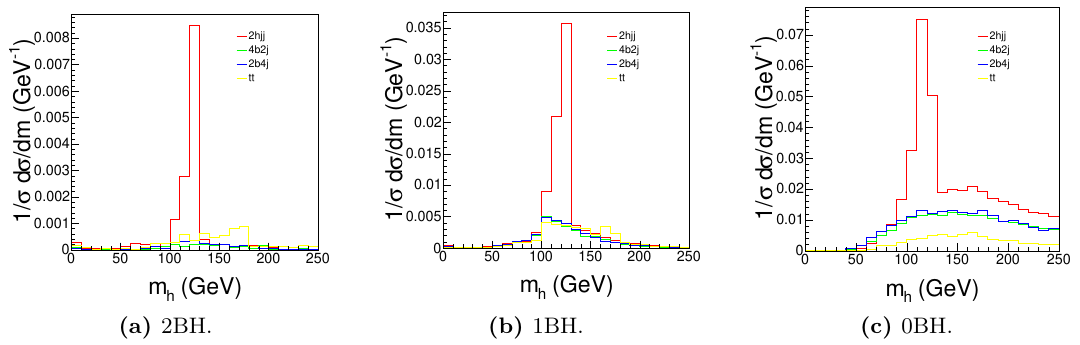
Figure 1 . Distributions of the reconstructed Higgs mass with (a) 2-boosted Higgs events, (b) 1-boosted Higgs events, and (c) 0-boosted Higgs